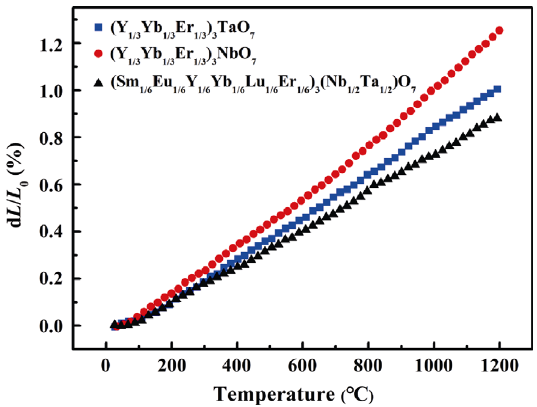
Fig. 4 Linear thermal expansion curves of HE RE 3 TaO 7 , RE 3 NbO 7 , and RE 3 (Nb 1/2 Ta 1/2 )O 7 measured from room temperature to 1200 ℃